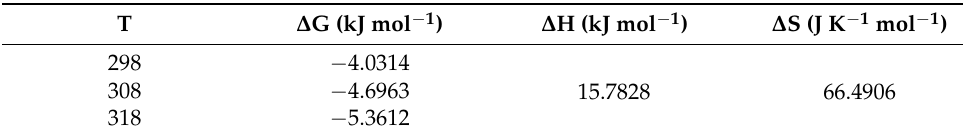
Table 5. Thermodynamic parameters for the adsorption of MB onto SDB-6-K at different tempera- tures.